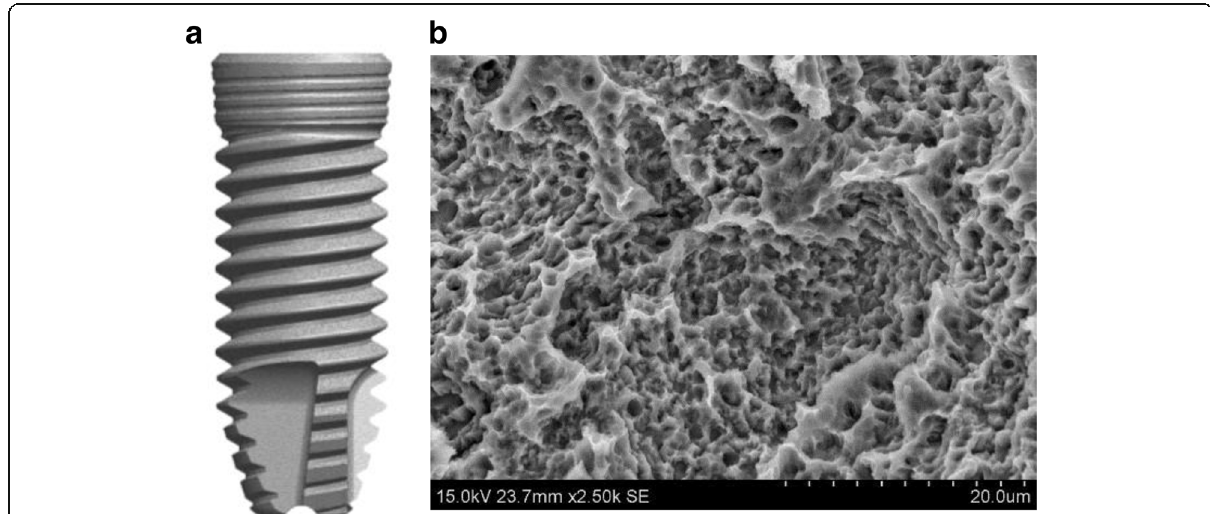
Fig. 1 Genesio® Plus implant with Aanchor surface. Scheme of the dental implant body for the Genesio® Plus implants with Aanchor surface used. a Overview picture of Genesio® Plus implants with Aanchor surface. b Image from scanning electron microscopy. Both pictures were provided by GC Corporation. To obtain osseointegration from an early stage, the dental implant body was treated with sandblasting and acid etching from the neck to